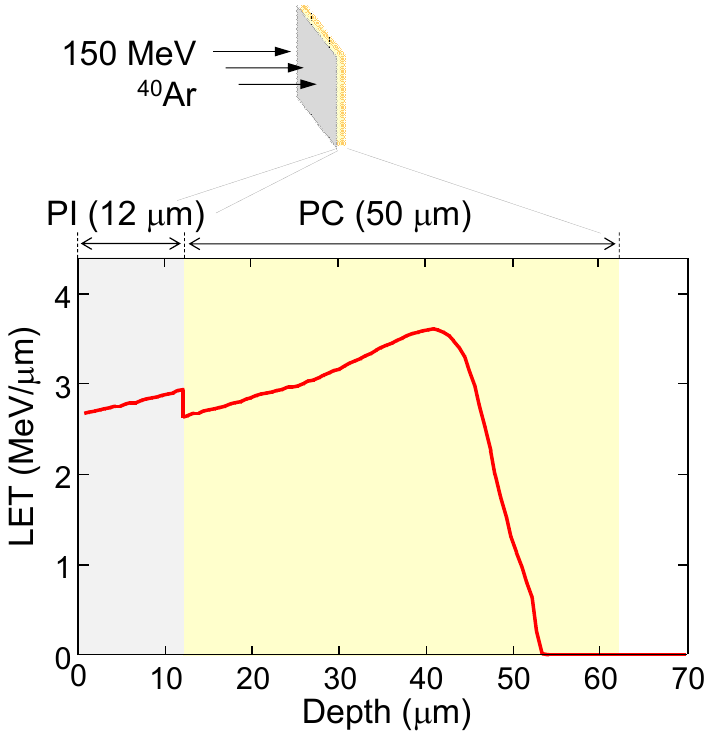
Figure 1. Depth profile of the LET of 150 MeV 40 Ar ions for a 12μm-thick PI overlaid on 50μm-thick PC, which was calculated by our SRIM simulation.